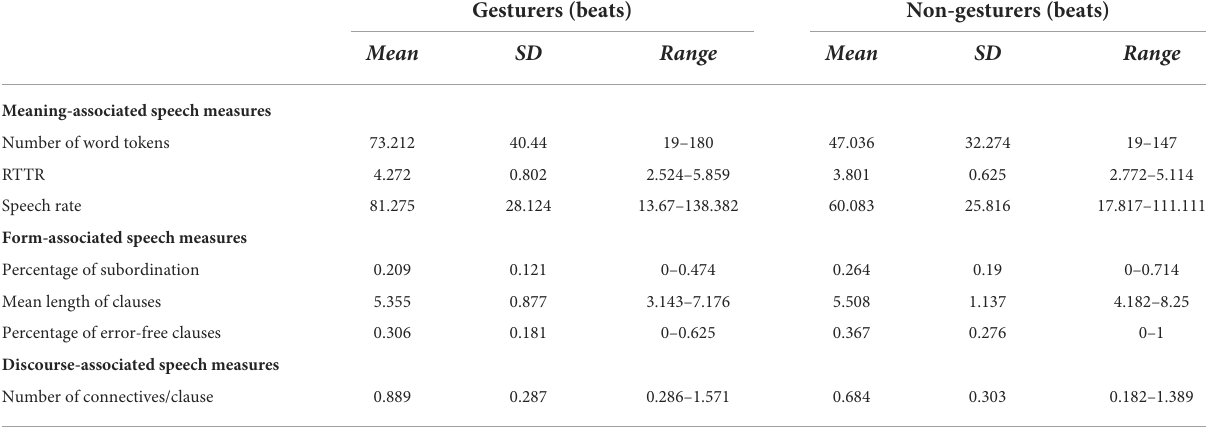
TABLE 8 Descriptive statistics of speech measures for gesturers and non-gesturers of beats.